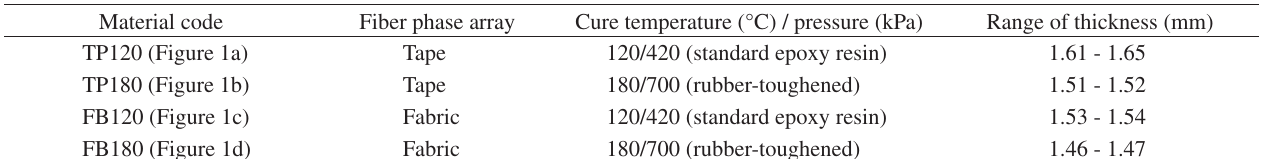
Table 1. Résumé of materials tested.